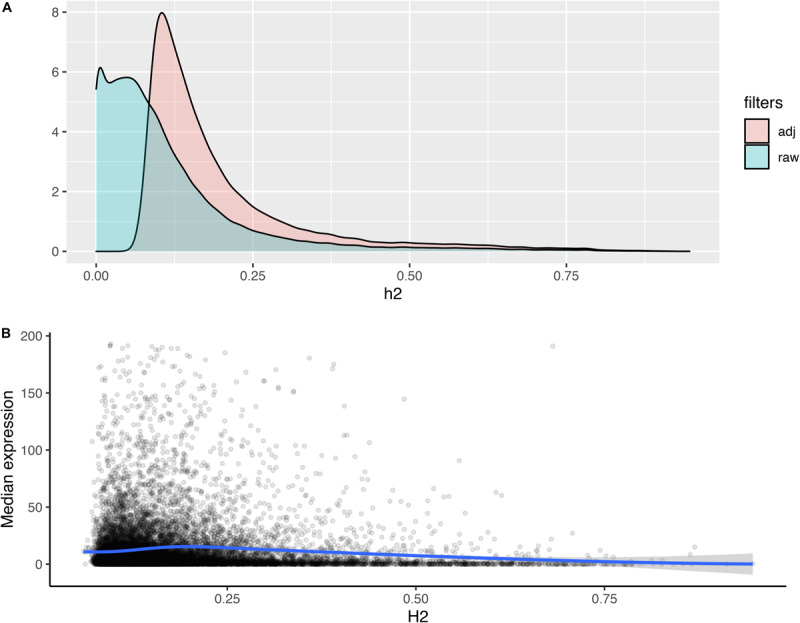
Distribution of heritability estimates and its relation to isoform expression. (A) Stacked bar plot of the distributions of heritability estimates for all isoforms (raw) and the subset of isoforms with heritability greater than expected by chance (adj; permutation test, p-value < 0.01). (B) Loess plot depicting the correlation between the median expression of an isoform (y) and the heritability estimate for an isoform (x). Blue line represents rs = –0.14.